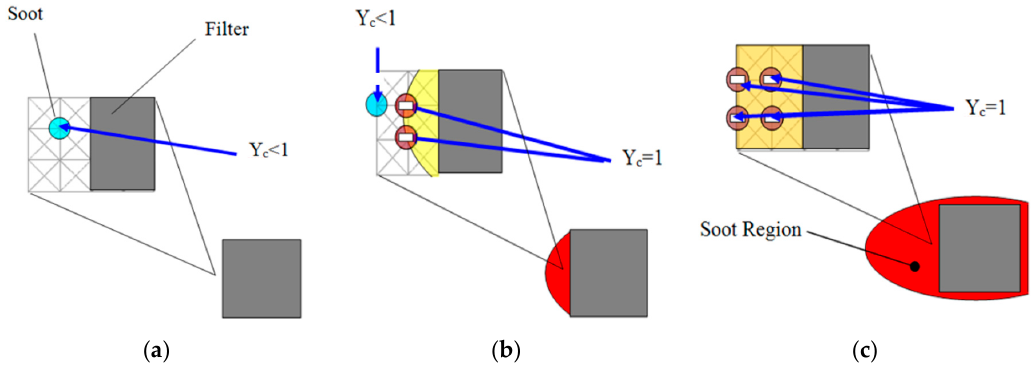
Figure 1. Soot deposition model. ( a ) Time step of IT 1 ; ( b ) Time step of IT 2 ; ( c ) Time step of IT 2 + 1.